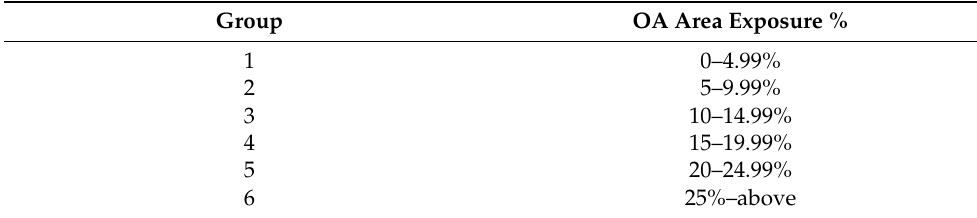
Table 5. Pictorial group classification based on 5% increments.